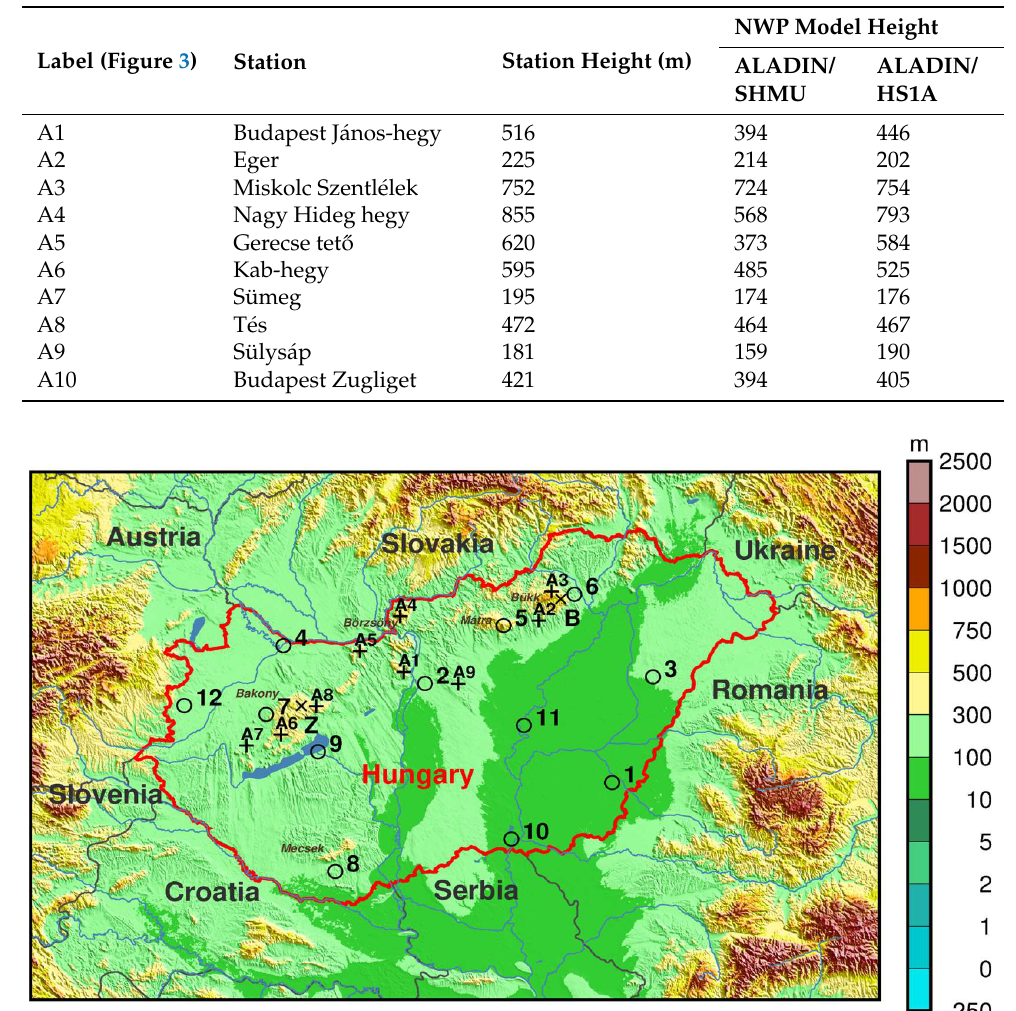
Figure 3. Map with positions of OMSZ synoptic weather stations used for wet snow climatology and return period calculation (circles, numbers 1–12, see Table 1). Positions of AWS stations selected for the wet snow case studies of 19–20 April 2017 and 12–13 April 2021 are highlighted by “plus” symbols and denoted A1–A8 (see Table 2). Positions of observed wet snow accretion at Zirc (Z) and Bükkszentkereszt (B) are marked with X. Some mountains mentioned in the text (Bükk, Mátra, Bakony, etc.) are also displayed. The background is orography (in m a.s.l.) from a subset of the SRTM15+ database [24]. The map depicts area between 15° E, 45° N (southwestern corner) and 24° E, 49° N (northeastern corner).